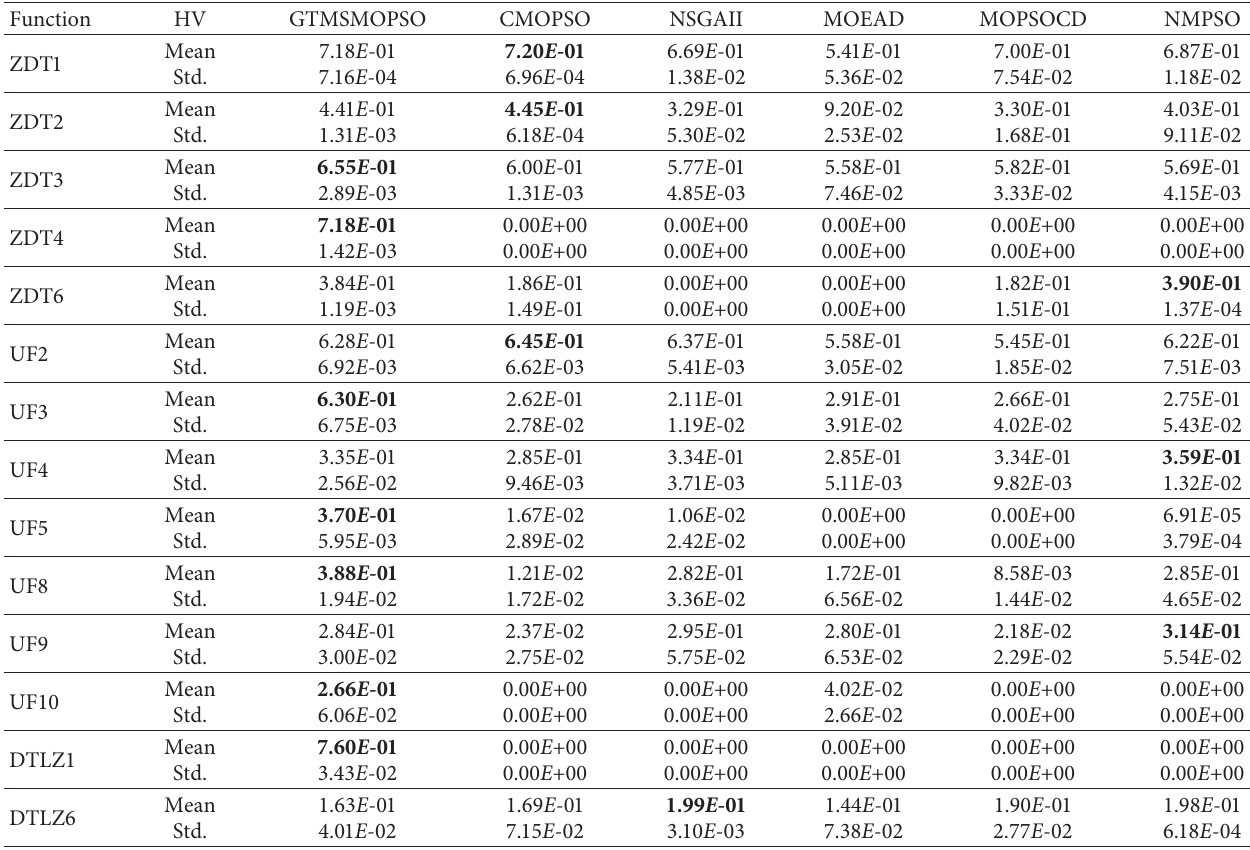
Table 2: The HV value of the algorithm on 14 test